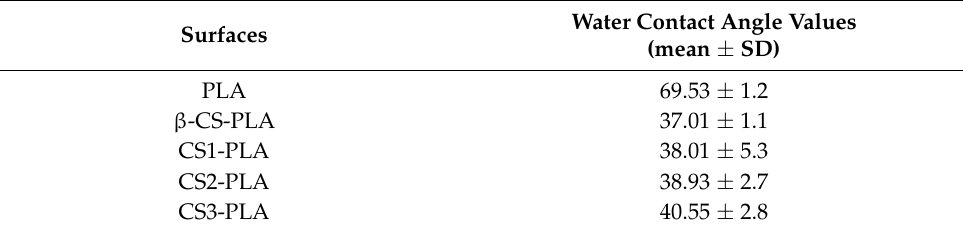
Table 1. Water contact angle values of polylactic acid (PLA) and chitosan (CS)-coated PLA